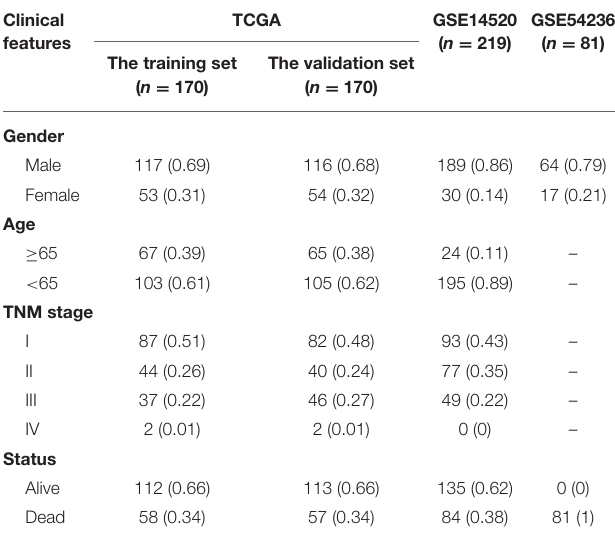
TABLE 1 | Clinical information of HCC patients. Clinical